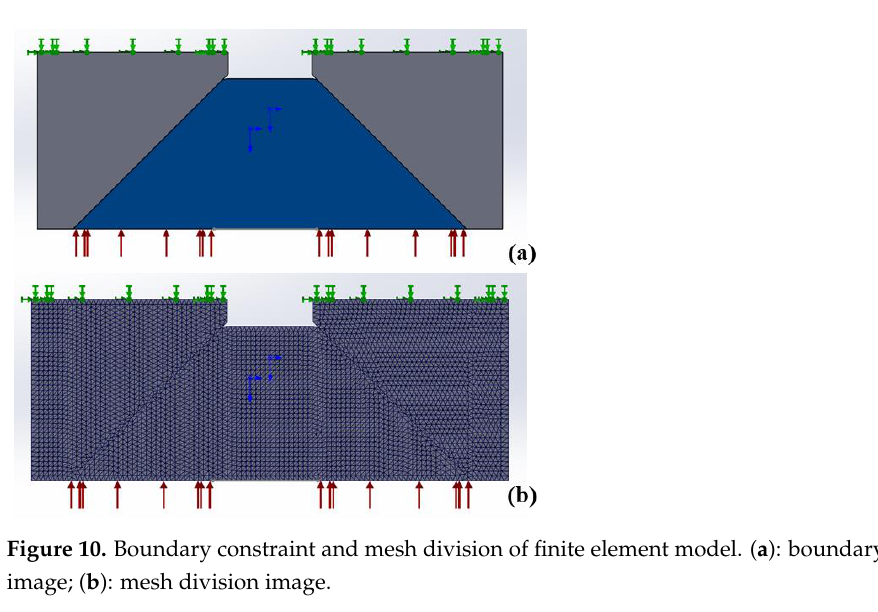
Figure 9. Relationship of the clear aperture of the sample with the pressurization surface.